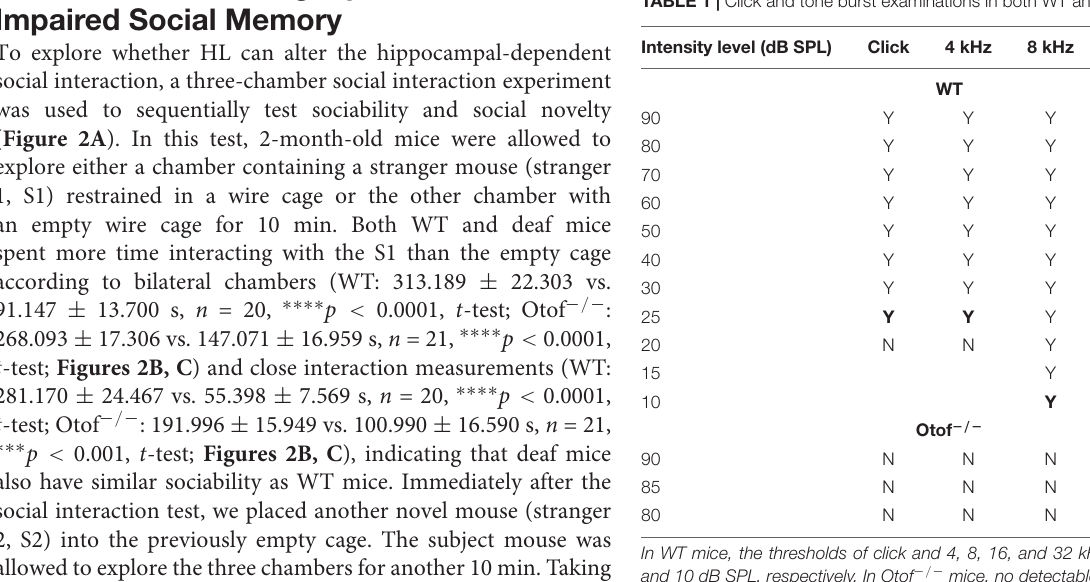
TABLE 1 | Click and tone burst examinations in both WT and Otof − / −